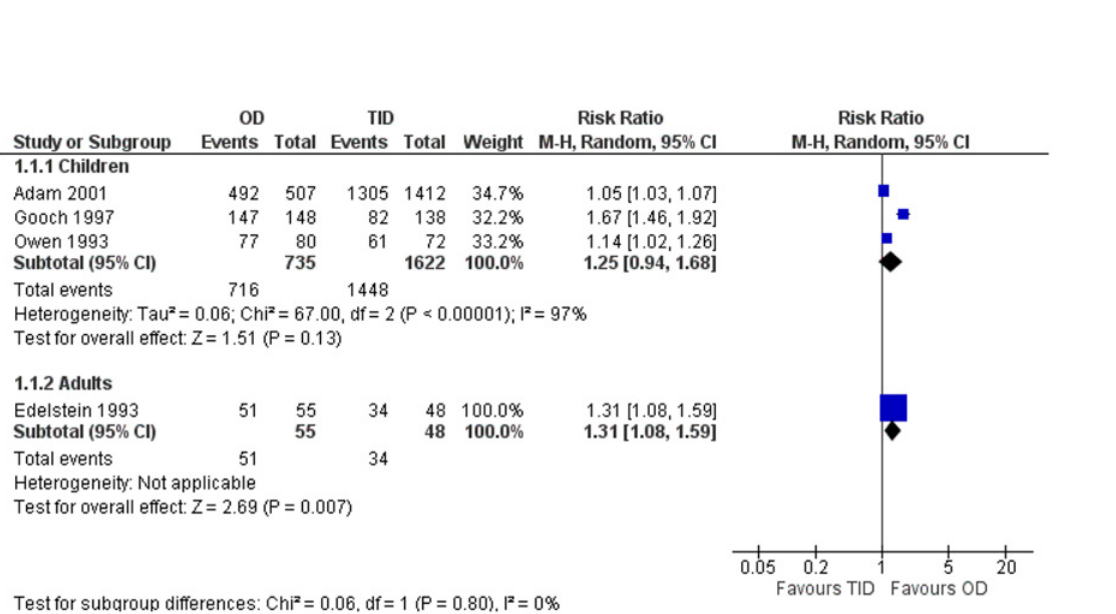
PLOS ONE | DOI:10.1371/journal.pone.0116207 January 5,